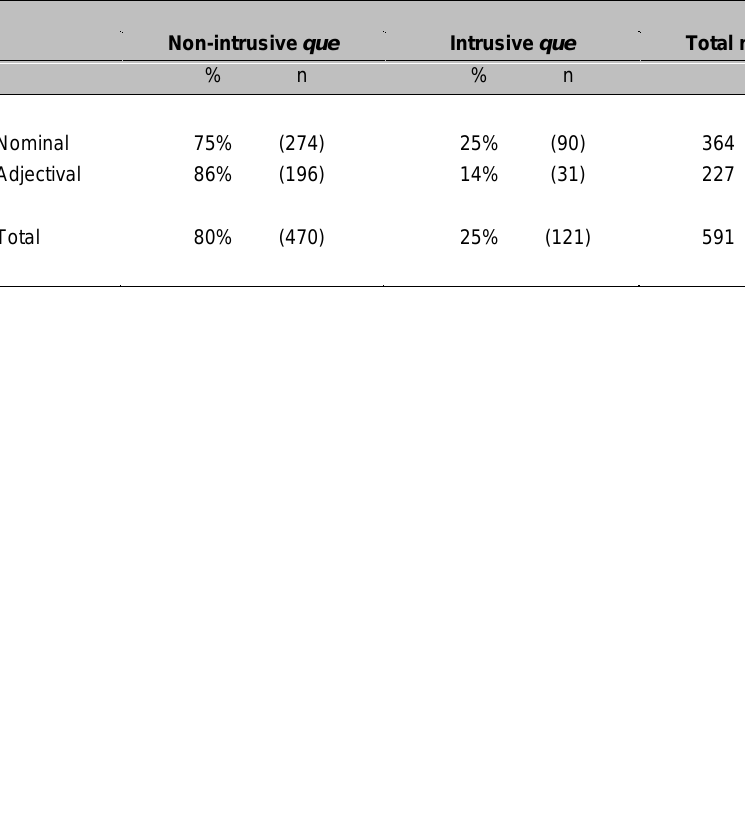
Table 1: Cases of intrusive que in the Andean Spanish